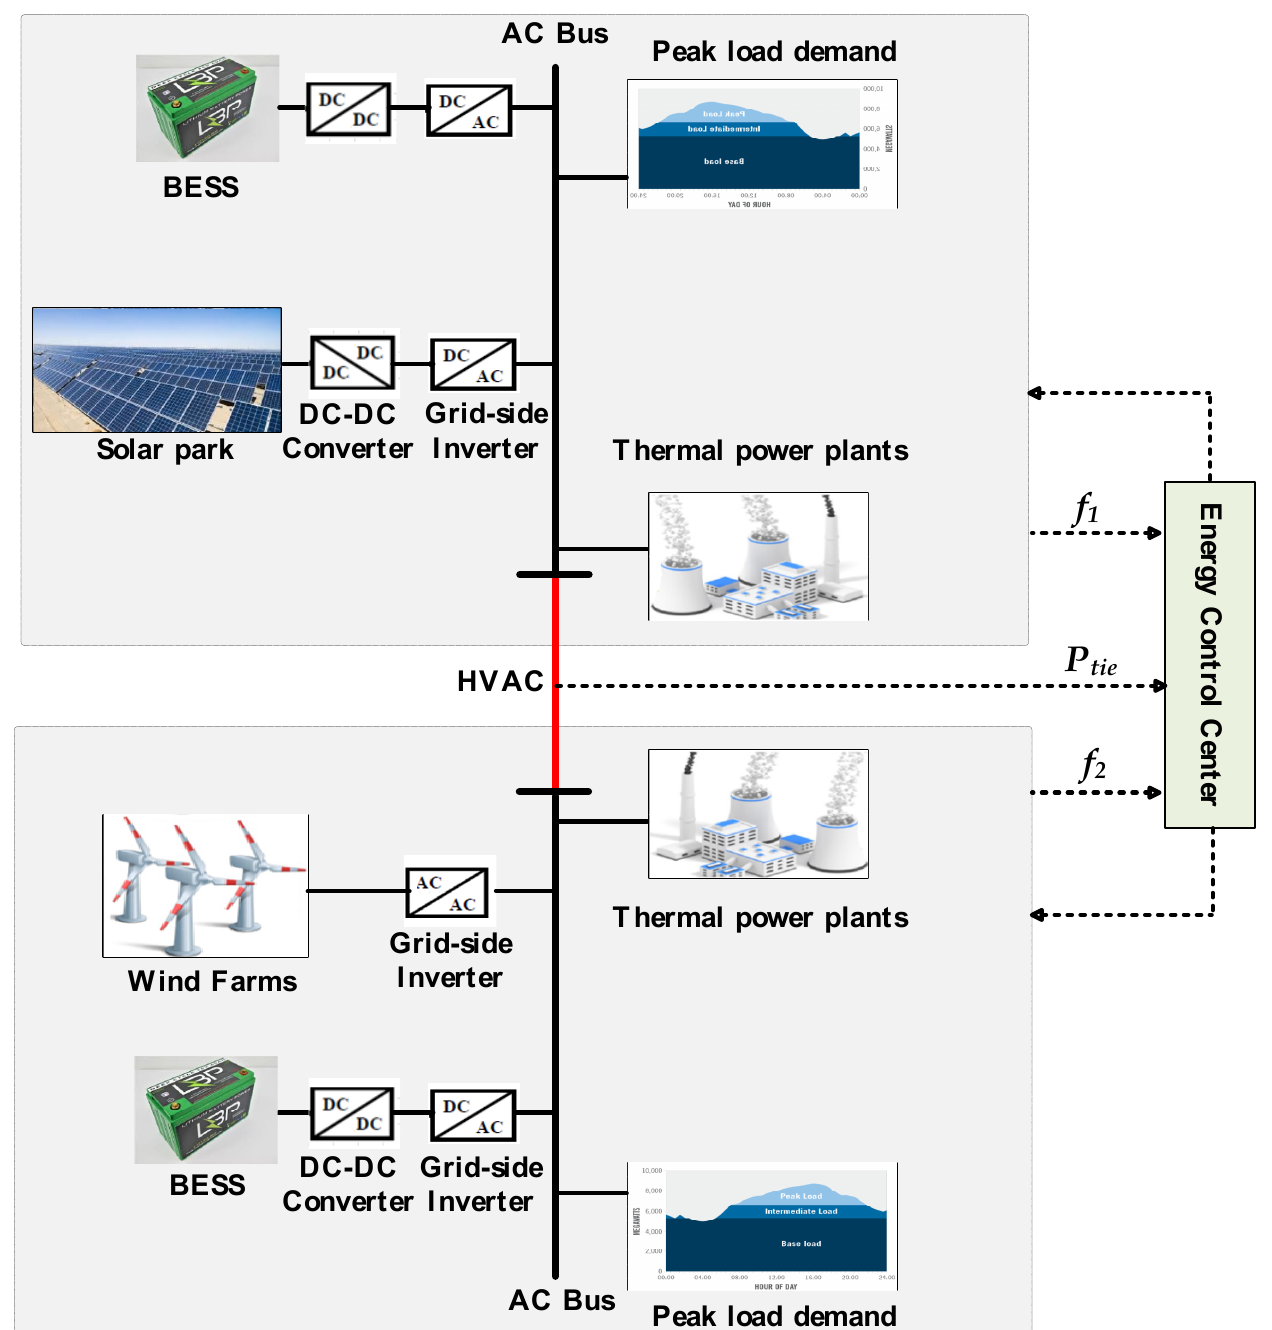
Figure 1. The basic structure of the proposed two ‐ area interconnected power system. To model the studied system, the low ‐ order models of the individual generation units may be considered suitable for controlling interconnected power systems [1]. The linear model of the studied two ‐ area interconnected power system with the VIC technol ‐ ogy is shown in Figure 2. Additionally, the model parameters are presented in Table 1. Each area has a domestic load that is treated as a disturbance in the model. Wind and solar farms are also treated as disturbances. The deviation in the frequency of the proposed